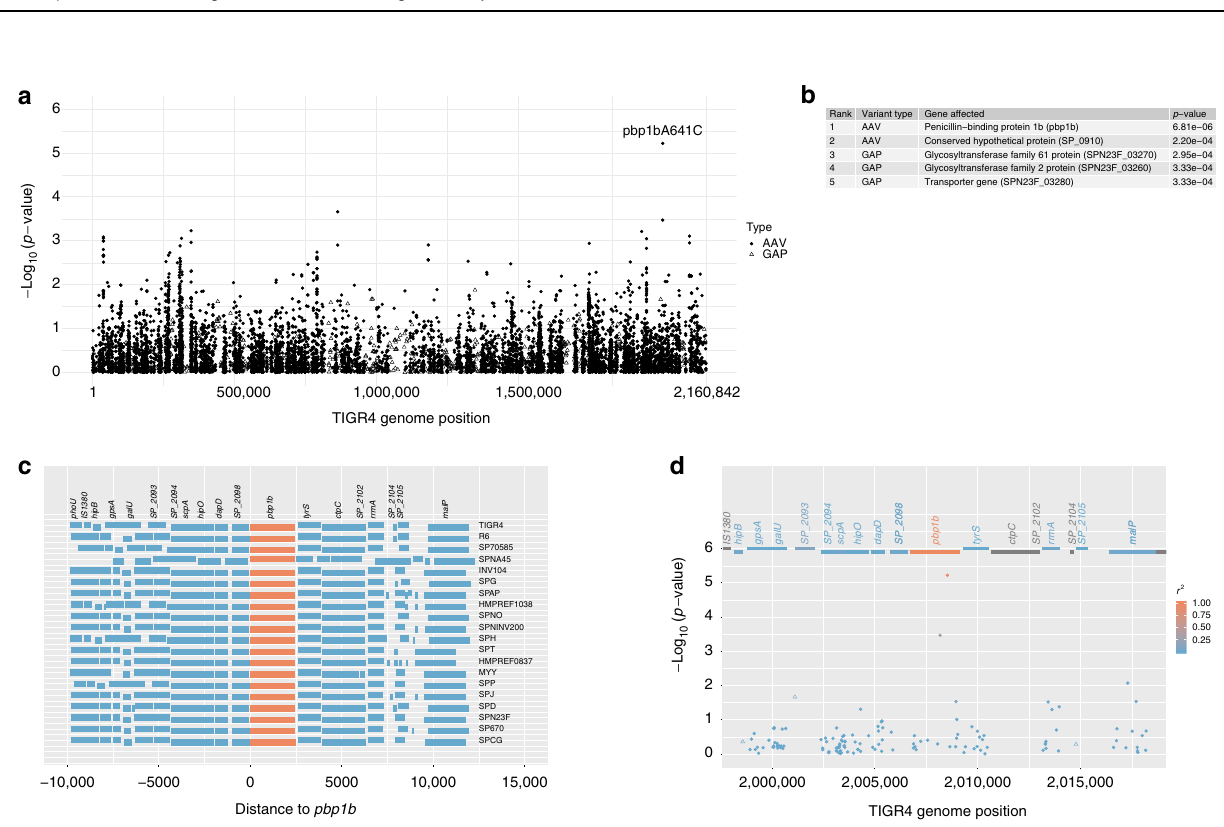
Fig. 1 Association between pneumococcal variants and meningitis in an exploratory sample. a P -values ( − log10 transformed) of the test variants assessed by a linear mixed-effects model (LMM) controlling for population structure. Coding DNA sequence (CDS) variants were mapped to the corresponding position of the TIGR4 reference genome. Solid dots: non-synonymous CDS SNPs causing amino acid variations (AAVs). Open triangles: gene absence/ presence variations (GAPs). b A list of top fi ve hits form the association study. c Genomic structure within − 10 and + 10 kb of the pbp1 b gene in 20 reference pneumococcal genomes. The pbp1 b gene is colored in orange. d Regional plot of variants near the pbp1b gene. AAVs (solid dots) and GAPs (open triangles) are colored according to their linkage disequilibrium (r 2 value) with the lead variant ( pbp1b